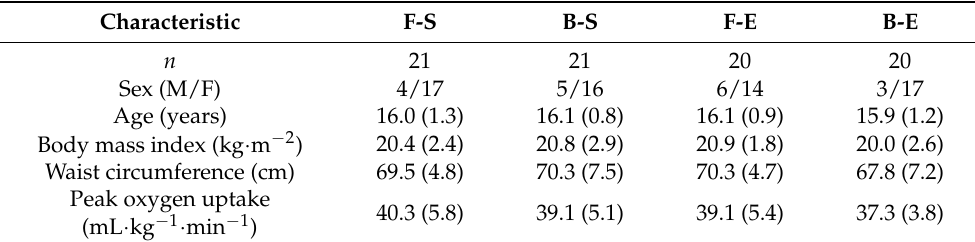
Table 1. Physical characteristics of participants in the experimental